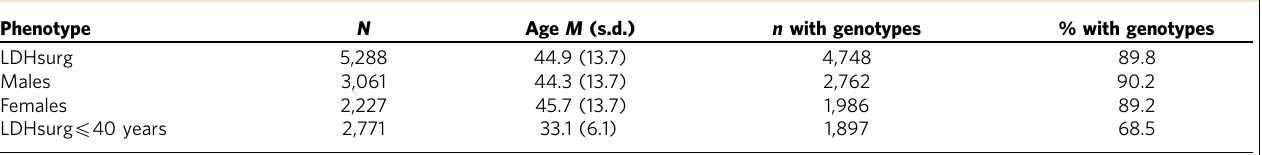
Table 1 | Demographics of